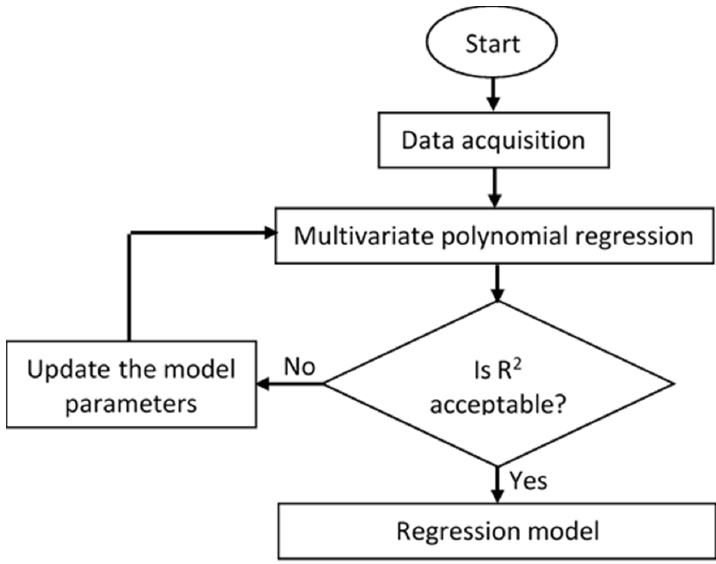
Figure 13. The MPR model flowchart.